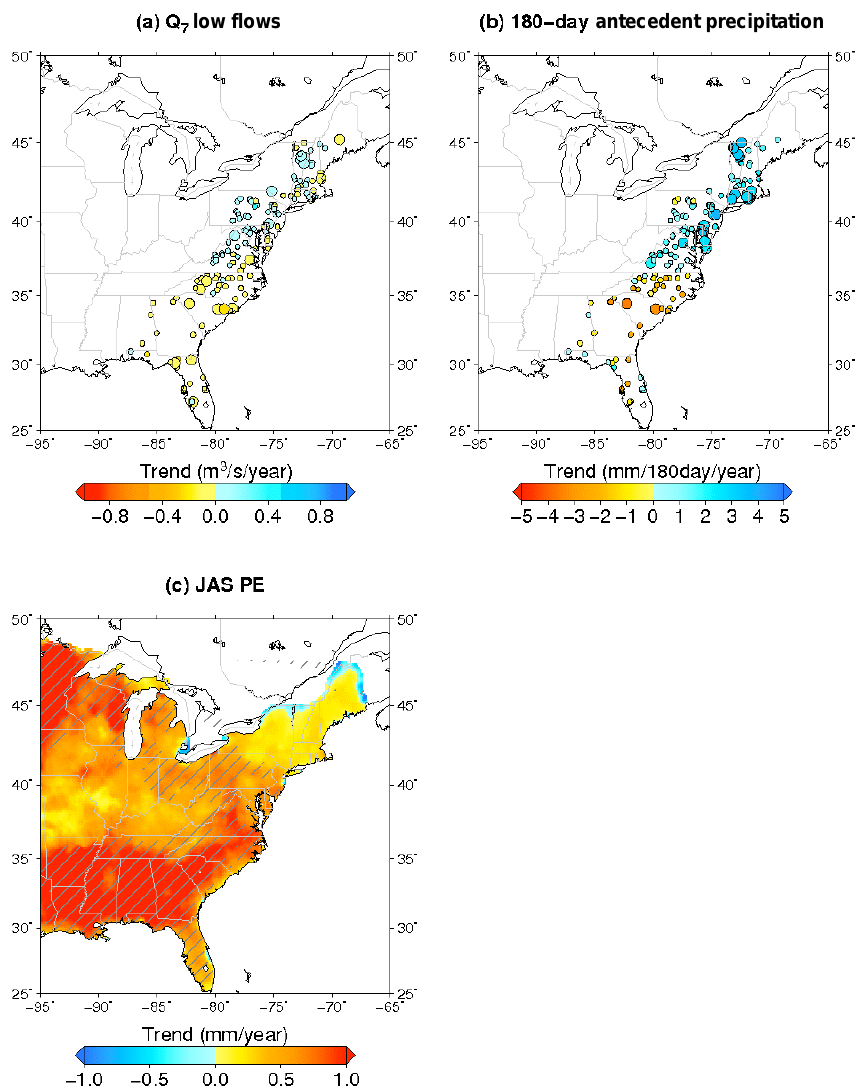
Figure 10. (a) Trend in Q7 low flows for 1951–2005 for the warm season. (b) Corresponding trend in 180-day antecedent precipitation. For (a) and (b) , trends that are statistically significant at the 0.05 level are shown in large symbols. (c) Trend in July–August–September (JAS) potential evaporation for 1979–2012. Statistically significant trends are shown by